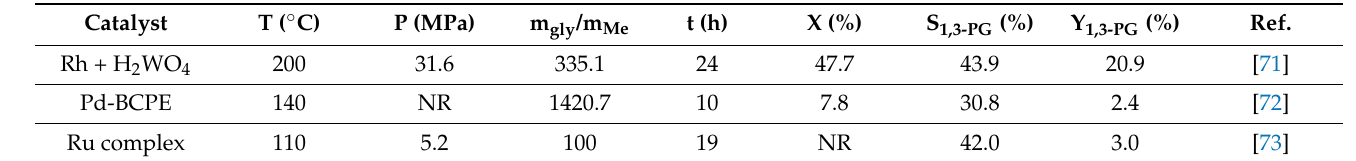
Table 1. The hydrogenolysis of glycerol to 1,3-PG using homogeneous Pd, Ru, and Rh catalysts operating in liquid phase batch